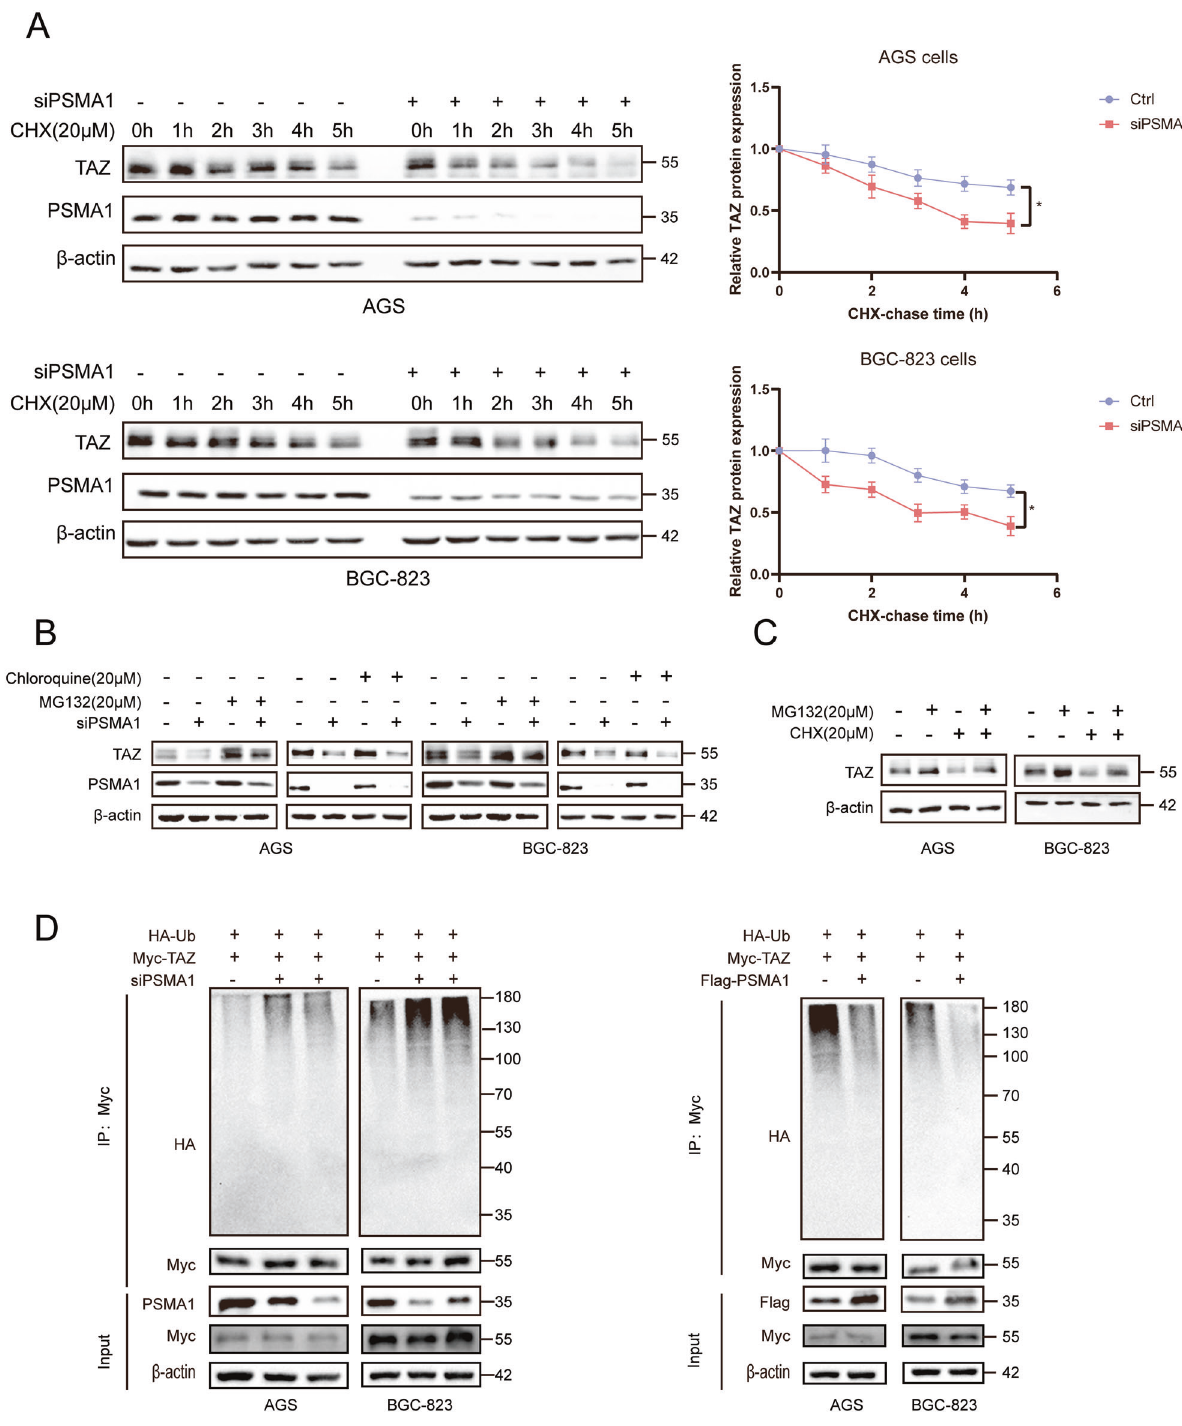
Fig. 3 PSMA1 stabilized TAZ through deubiquitination. A AGS and BGC-823 cells transfected with siPSMA1 were treated with 20 μ M cycloheximide (CHX) for 0, 1, 2, 3, 4, and 5 h, and the PSMA1 and TAZ protein levels were detected by western blot. B Western blotting was conducted to measure TAZ protein level after treatment with 20 μ M MG132 and treatment with 20 μ M Chloroquine (CQ) in knock-down PSMA1 and control GC cells. C AGS and BGC-823 cells were treated with 20 μ M MG132 accompanied by 20 μ M CHX for 6 h. D Western blotting was conducted to measure the level of ubiquitin when knocking down or overexpression PSMA1. PSMA1 is positively correlated with TAZ in clinical GC samples knockdown cells. Consistent results were observed in BGC-823 and predicts a poor survival outcome cells (Fig. 6B, C). Western blot assays in GC cells showed the We analyzed PSMA1 and TAZ expression in tumor samples and depletion of PSMA1 decreased the expression of C-Myc and PCNA, adjacent normal tissues from 94 GC patients using tumor while overexpression of TAZ rescued the proliferation ability in microarrays (TMA), along with their corresponding clinicopathologic PSMA1-knockdown cells (Fig. 6E). Cell Death and Disease (2022)